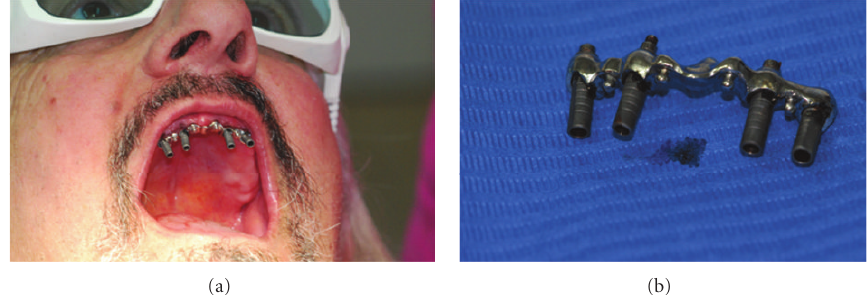
Figure 3: (a) The bar welded to abutments. (b) Bar and abutments removed from the mouth.